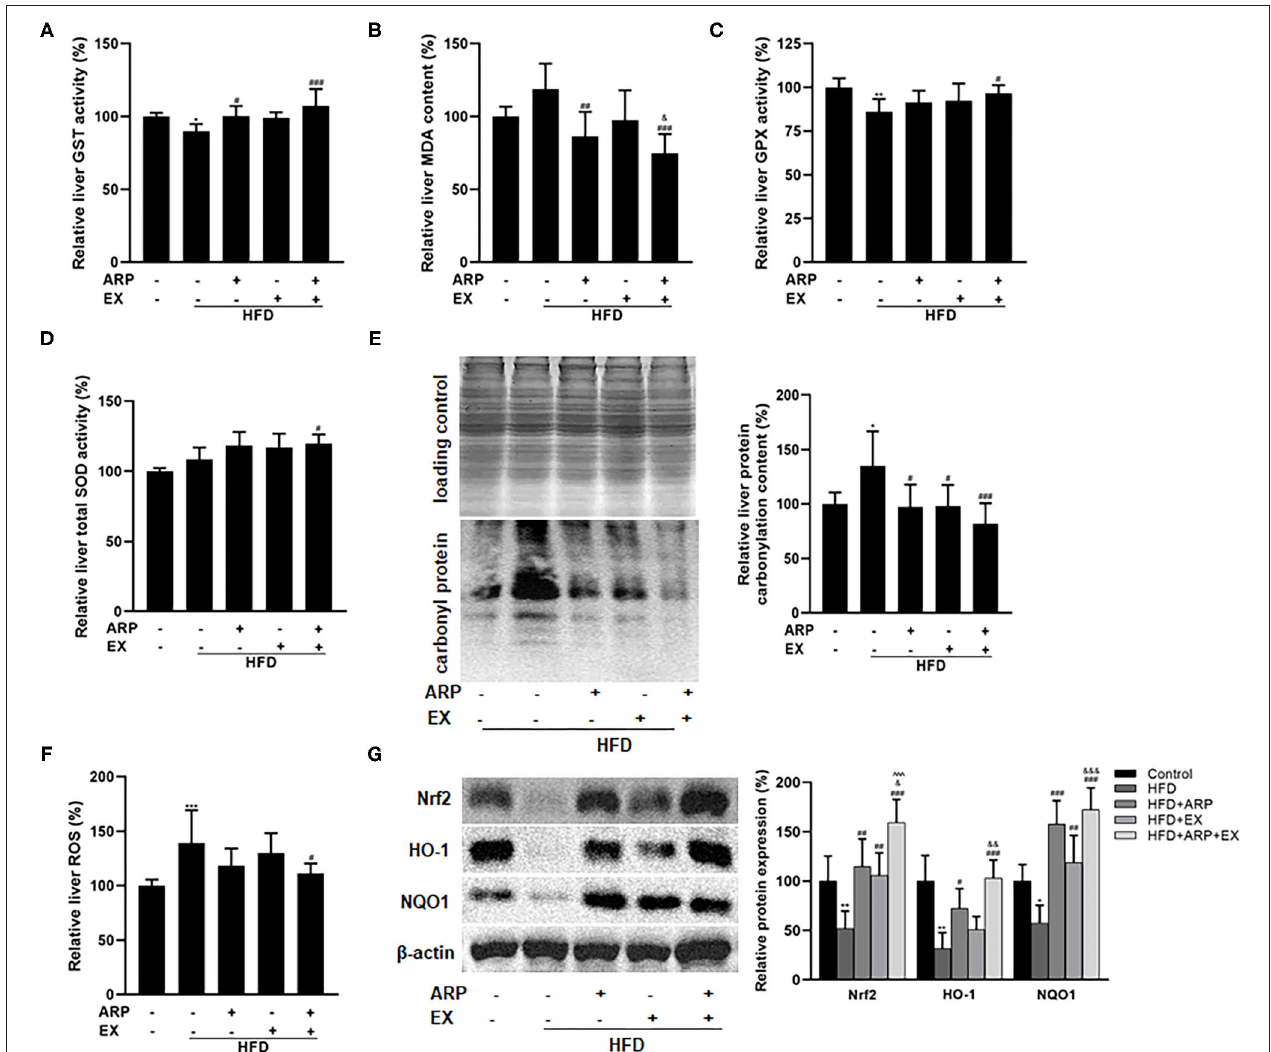
FIGURE 5 | Effects of ARP and EX on liver oxidative stress in HFD-fed mice. (A) Liver GST activity. (B) Liver MDA content. (C) Liver GPX activity. (D) Liver SOD activity. (E) Liver protein carbonyl content (left, western blot image; right, statistical analysis). (F) Liver ROS level. (G) Liver expression of Nrf2, HO-1 and NQO1 (left, western blot image; right, statistical analysis). All the values are exhibited as the mean ± SME, n = 8. * p < 0.05, ** p < 0.01 and *** p < 0.001 vs. related control group. # p < 0.05, ## p < 0.01, ### p < 0.001 vs. related HFD group; ∧∧∧ p < 0.001 vs. related HFD + AR group; & p < 0.05, && p < 0.01, &&& p < 0.001 vs. related HFD + EX